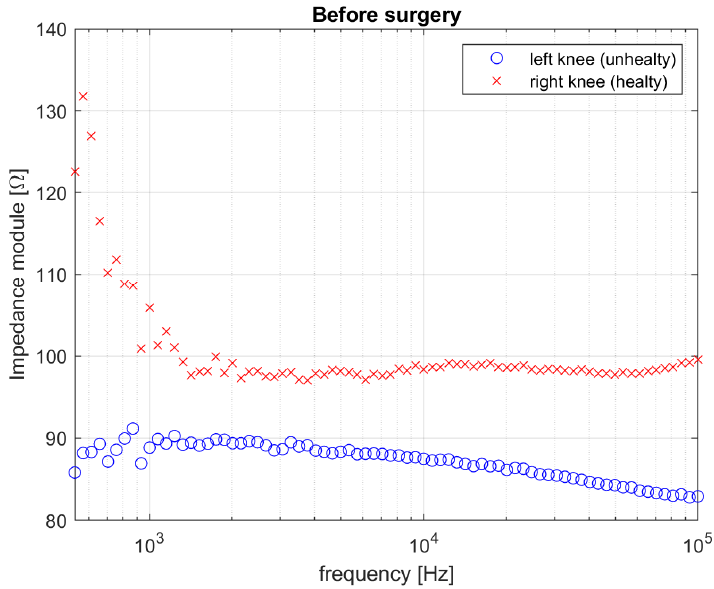
Figure 6. Impedance magnitude value for both right (healthy) and left (unhealthy) knee before sur- gery.